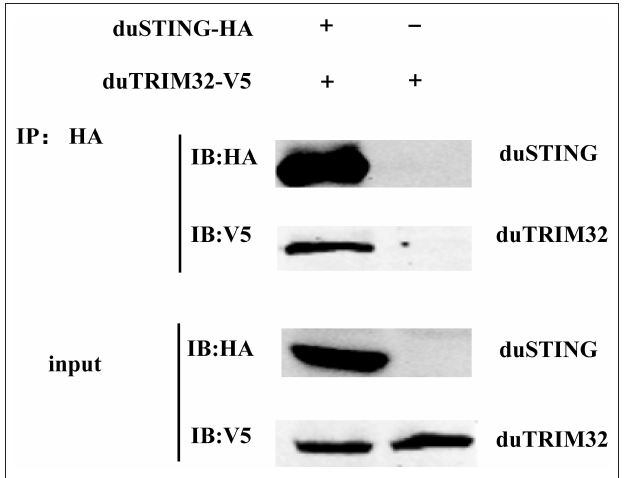
FIGURE 8 | Identification of the interaction between duTRIM32 and duSTING by Co-IP assays. The 293T cells were transfected with the pCAGGS-duTRIM32-V5 and/or pCAGGS-duSTING-HA. After 24h, the lysates were immunoprecipitated with anti-HA beads, followed by immunoblotting analysis with the indicated Abs.